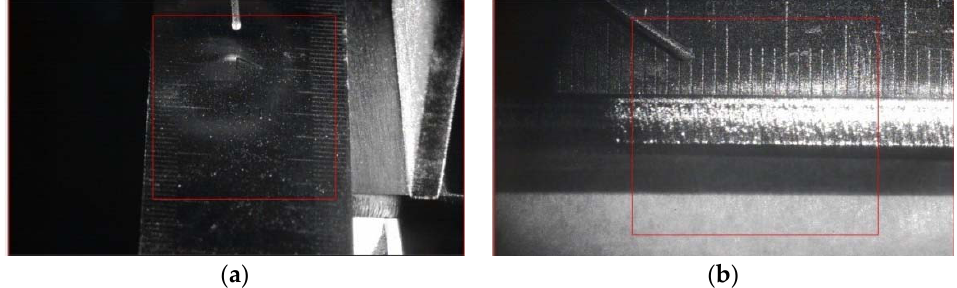
Figure 2. The calibration image of the captured field of view for hybrid welding. ( a ) The calibration image from camera one. ( b ) The calibration image from camera two.